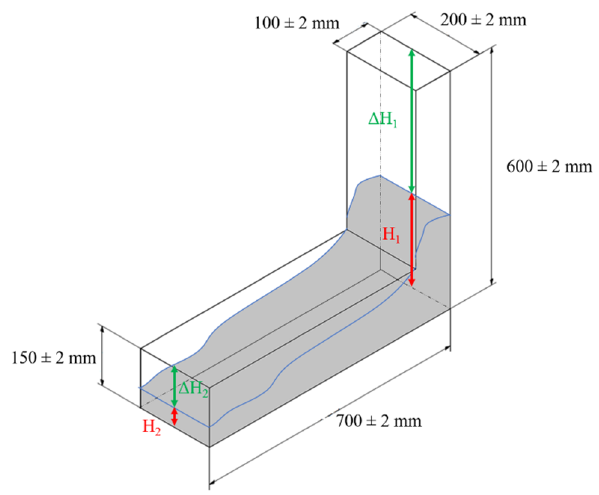
Figure 4. Assembly for L-box test.